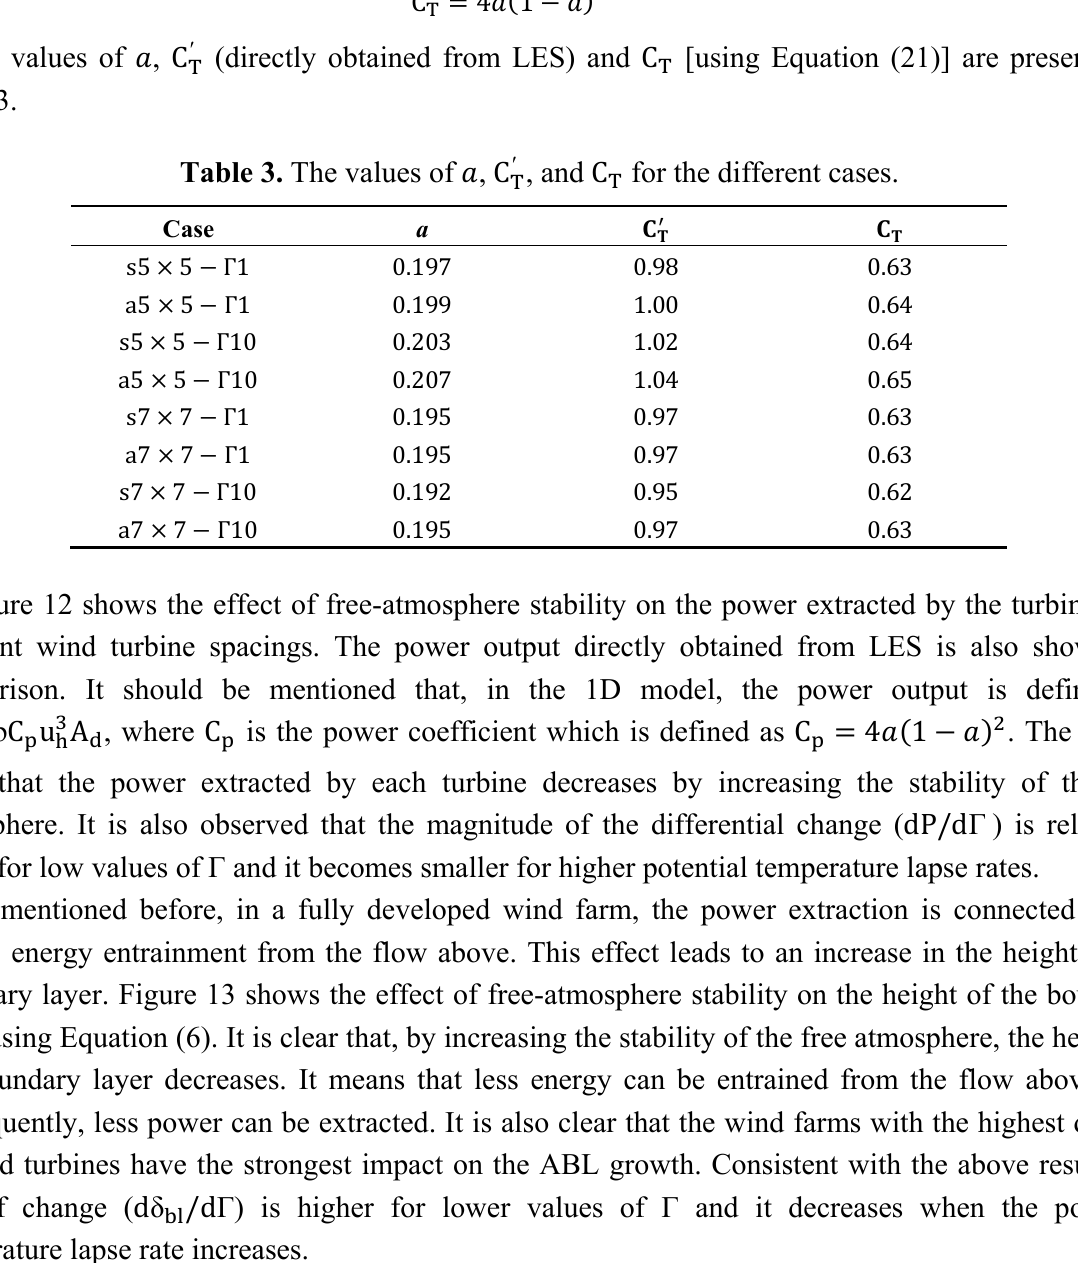
′ , and C for the different cases. (cid:2904) (cid:2904)